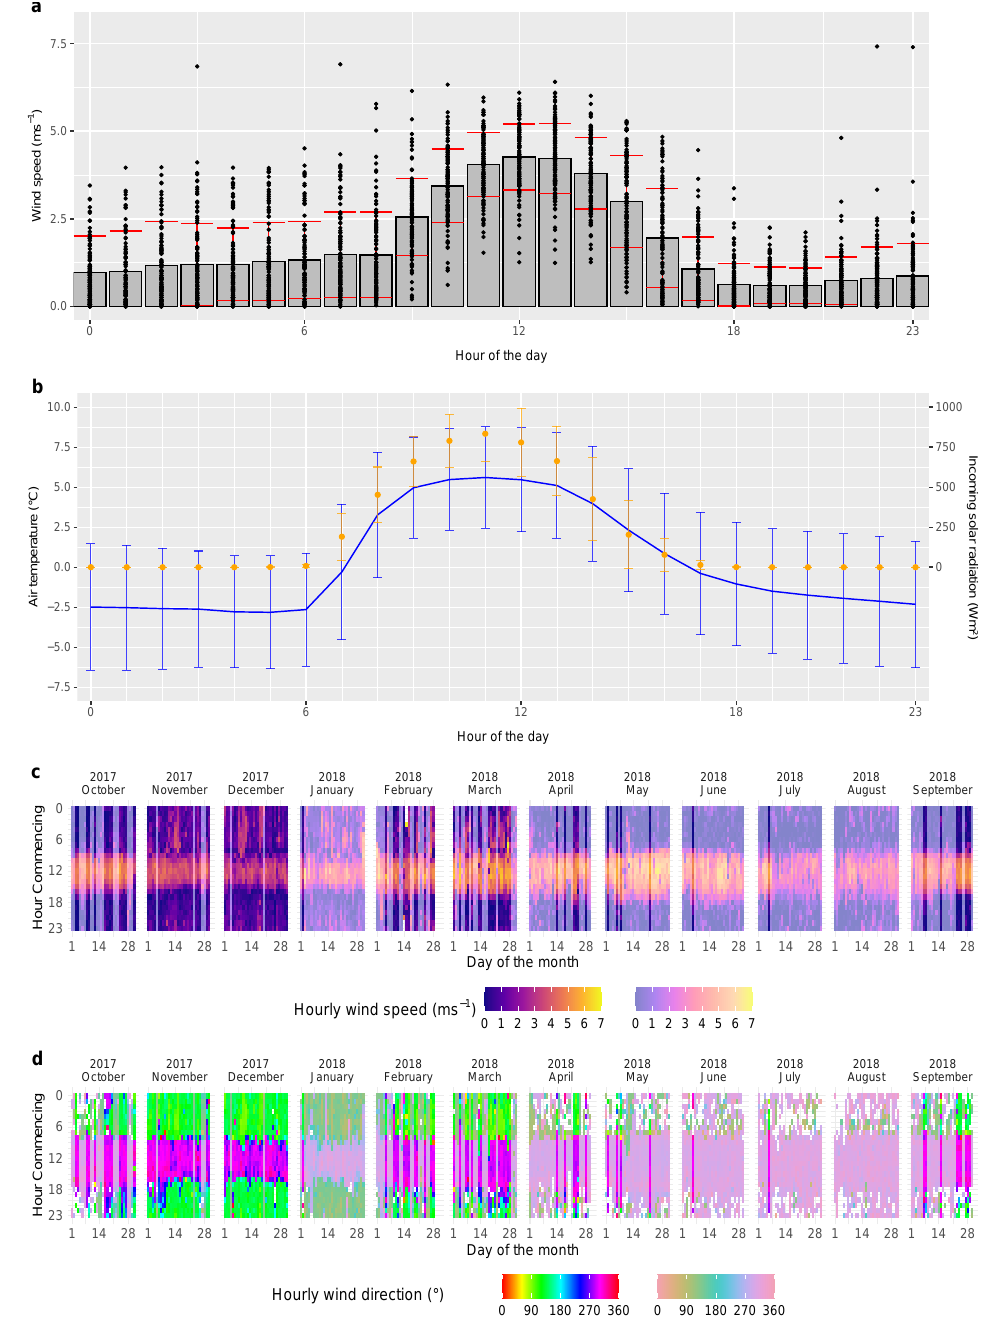
Figure 3. Wind speeds and direction during valley wind days at Na station. Topmost position ( a ) shows the hourly mean value of wind speed on the VWD as bar height with the red SD whisker. Hourly data are provided as black dots. Plot ( b ) consists of the hourly means of temperature (blue) and mean incoming solar radiation sums (yellow) on VWDs. Whiskers of one SD are added to the parameters in the respective colors. Mean hourly wind speeds for every hour in the observational period are shown in ( c ). The bottom plot ( d ) shows hourly wind directions in the same period. Calm hours are shown as transparent boxes in ( d ). Both ( c ) and ( d ) show the VWD data with higher